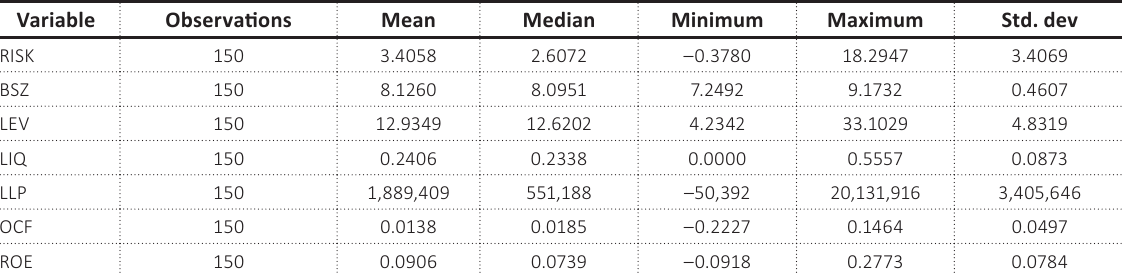
Source: Analytical data from EViews 10.